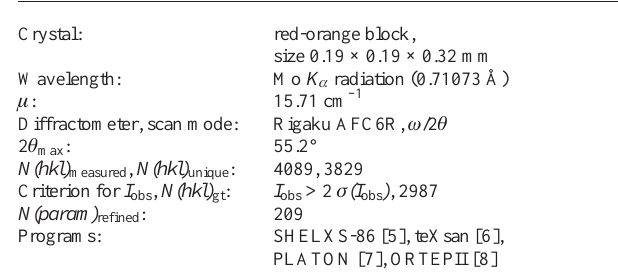
Table 1. Data collection and handling.